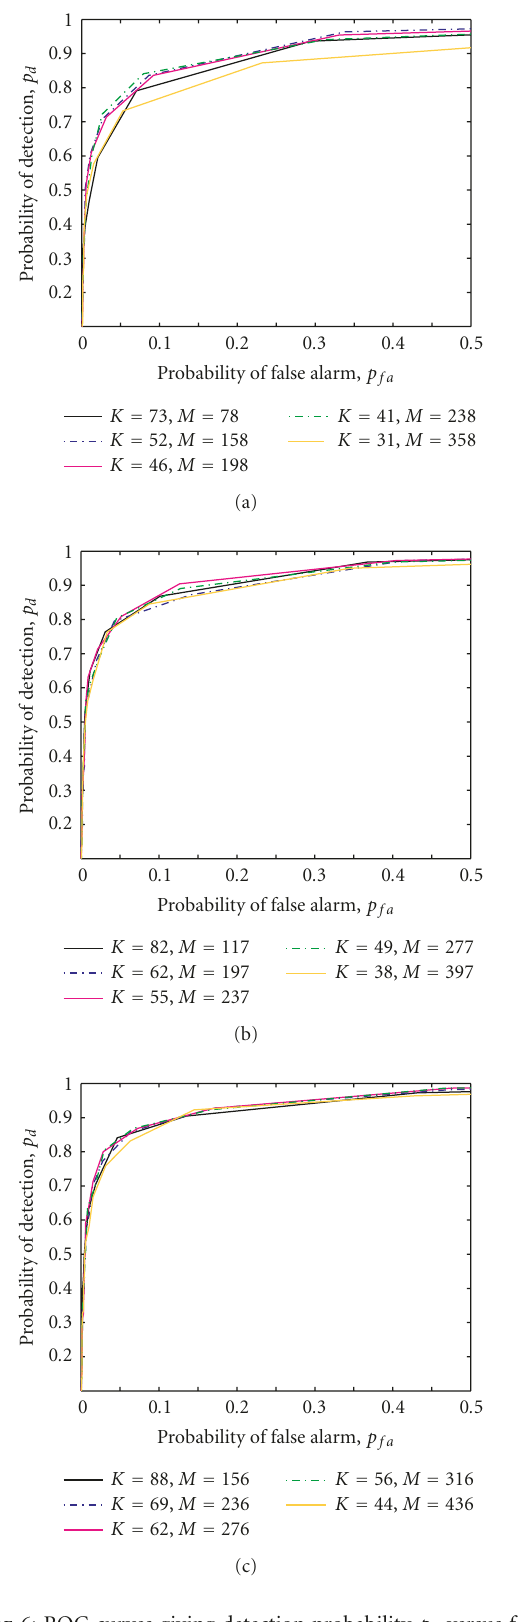
Figure 6: ROC curves giving detection probability p d versus false alarm probability p fa , when messages of length (a) 80 KB, (b) 100 KB, and (c) 120 KB are transmitted to establish the vision graph.